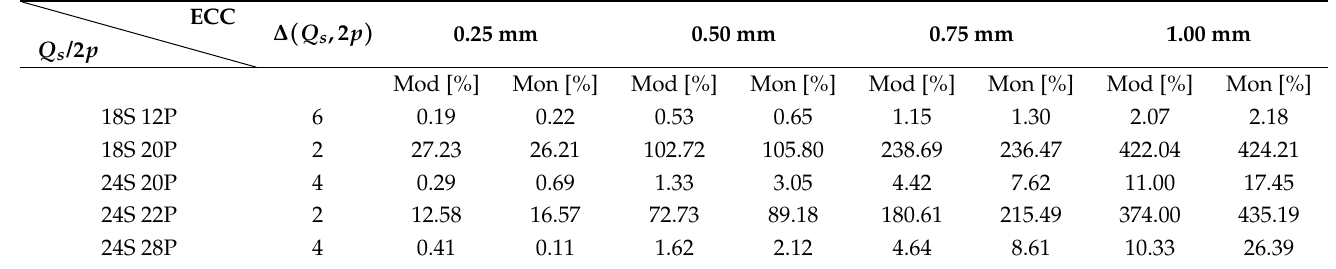
Table 11. Relative cogging torque increase of different PMSM and MPMSM slot/pole combinations in the presence of DE.